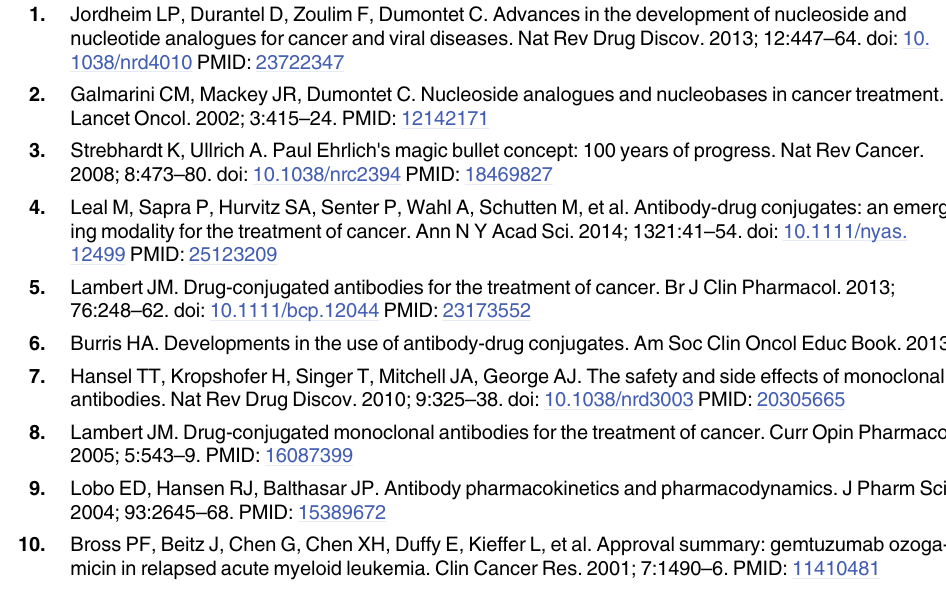
S4 Fig. Effect of dCK and fludarabine treatment on proliferation of cancer cell